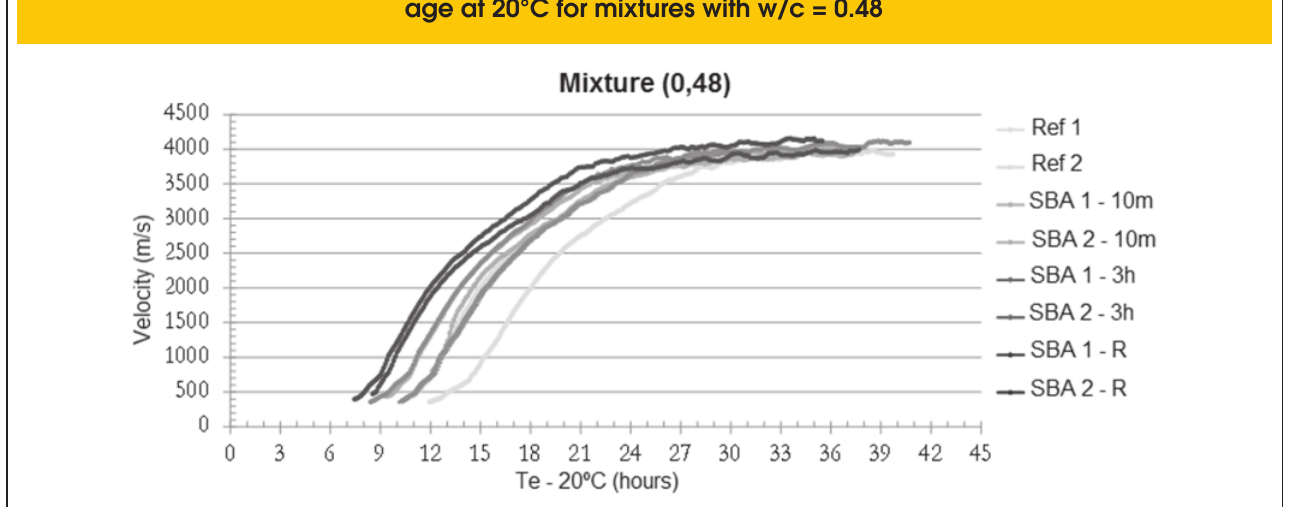
Figure 14 – Development of ultrasonic pulse velocity in equivalent age at 20°C for mixtures with w/c =